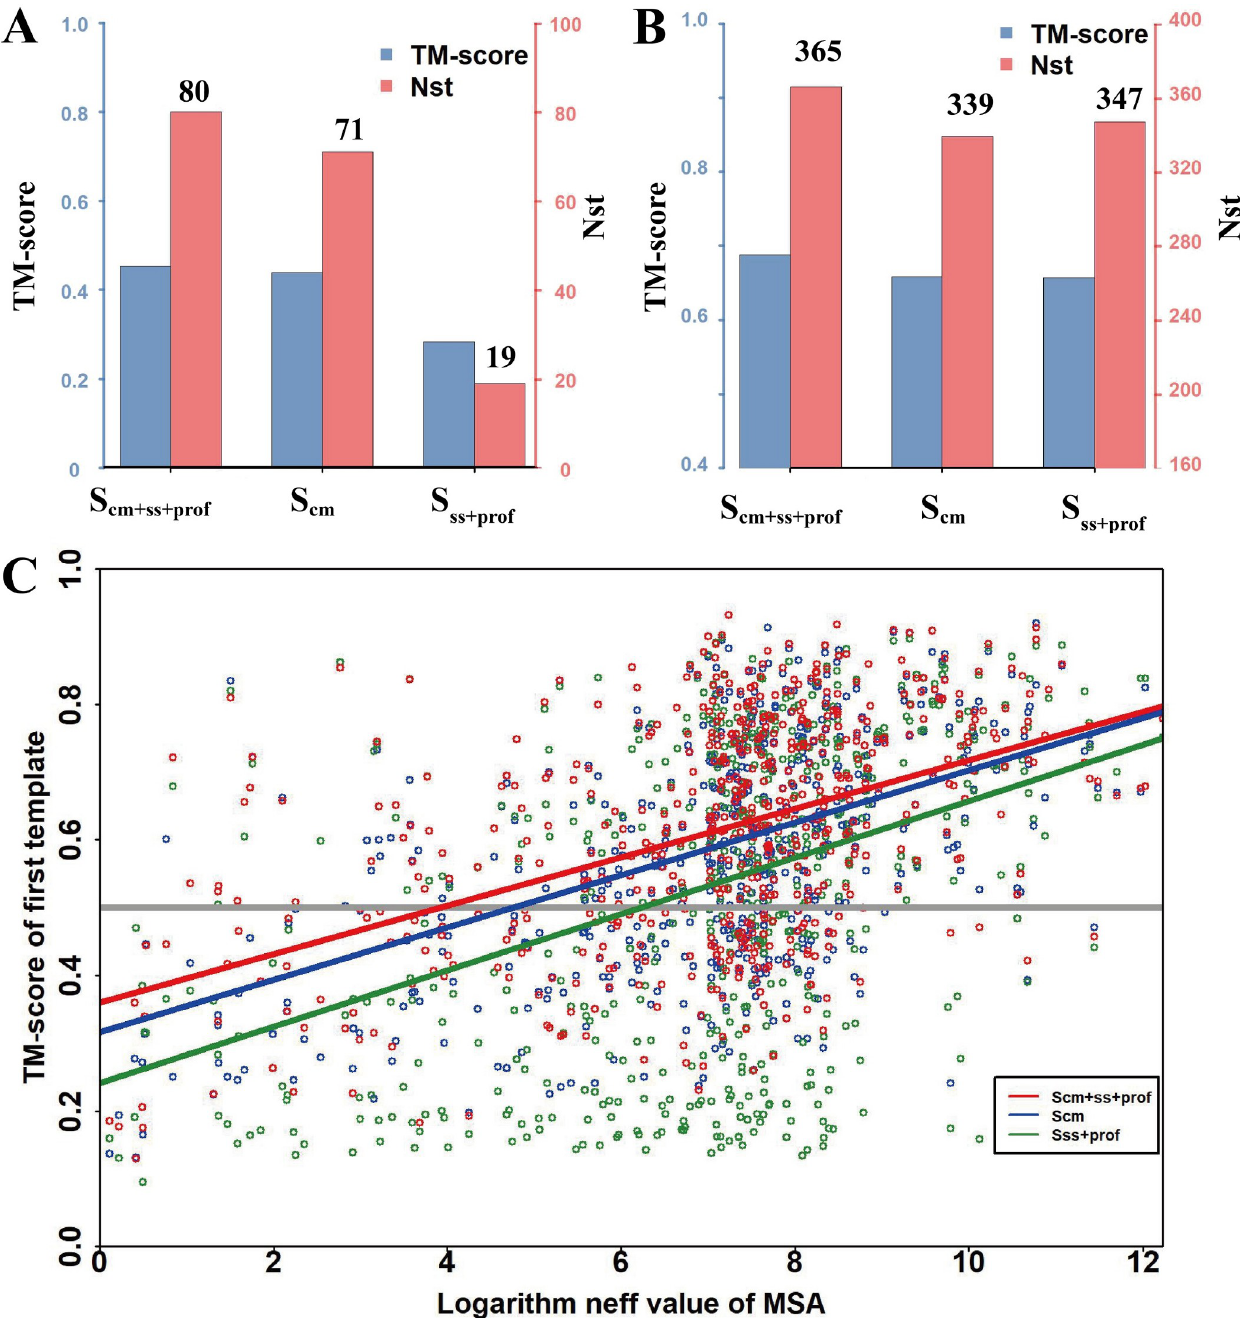
Fig 2. Performance of CEtheader on Benchmark Set-I, which was collected from the I-TASSER database. TM-score and N template TM-scores > 0.5) histograms for CEthreader using three different scoring functions on the 211 Hard targets (A) and 403 Easy targets (B). (C) The TM-score of the first template identified by CEthreader as a function of the logarithm of the MSA Neff value, where three scoring functions- S ss + prof (green (blue points) and S (red points)- were used by CEthreader. Linear regression was used to fit the correlation relationship between TM- points), S cm cm+ss + prof score and MSA Neff value for the three scoring functions, where the fitted relationships for S ss + prof (green line), S cm (blue line) and S cm+ss + prof (red line) are y = 0.242+0.042x, y = 0.317+0.039x, and y = 0.361+0.036x, respectively.